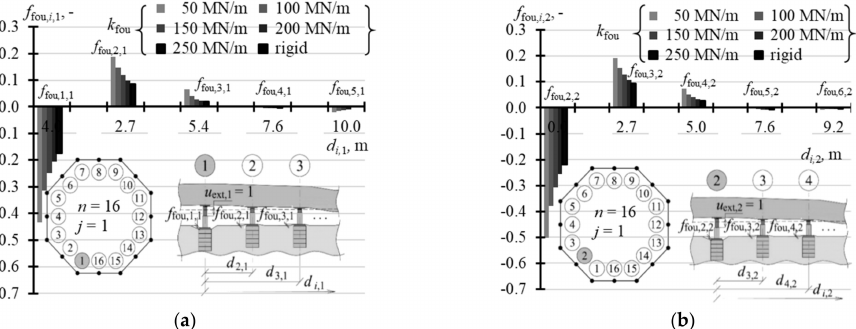
Figure 22. Elements of the matrix f fou of support displacements for different stiffness values k fou of the jack support when n = 16: ( a ) elements f fou ,i, 1 ; ( b ) elements f fou ,i, 2 .